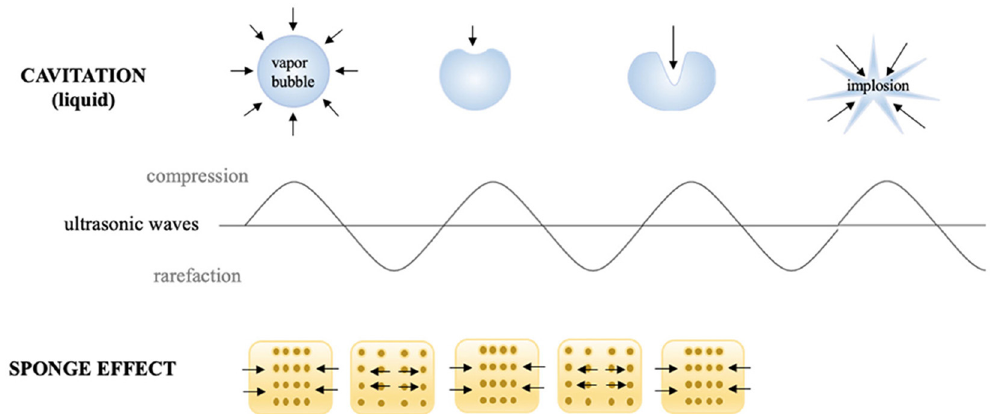
Figure 4. Schematic diagram showing the cavitation and sponge effect of ultrasound technology (Source: Astráin-Redín et al. [66]; permission to use not required).